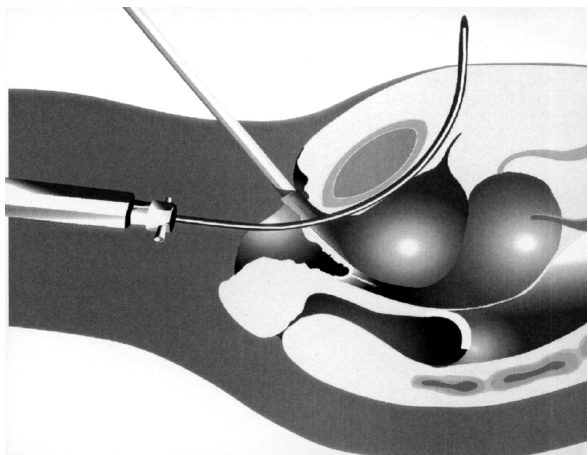
Figure 2 - After perforation of the endopelvic fascia, the needle is directed through the retropubic space close to the pubic bone.